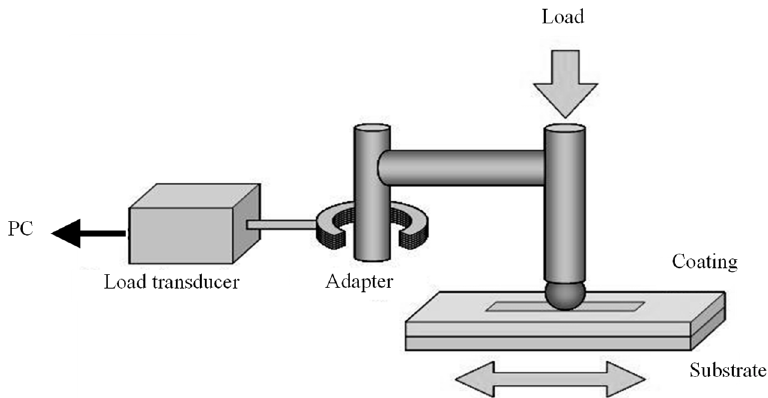
Figure 4. Experimental setup for the friction